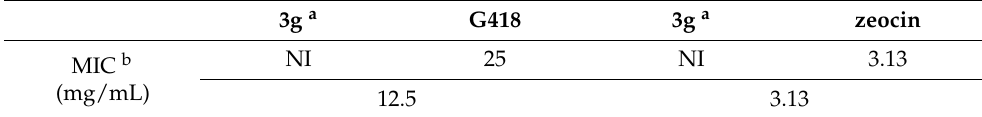
Table 4. The potentiation activity of 3g